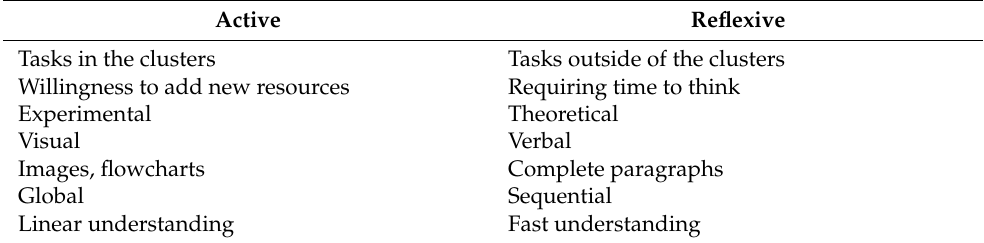
Table 2. Learning style characteristics of